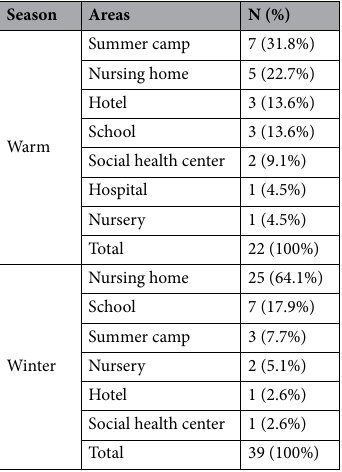
Table 2. Distribution of the location of outbreaks according to the